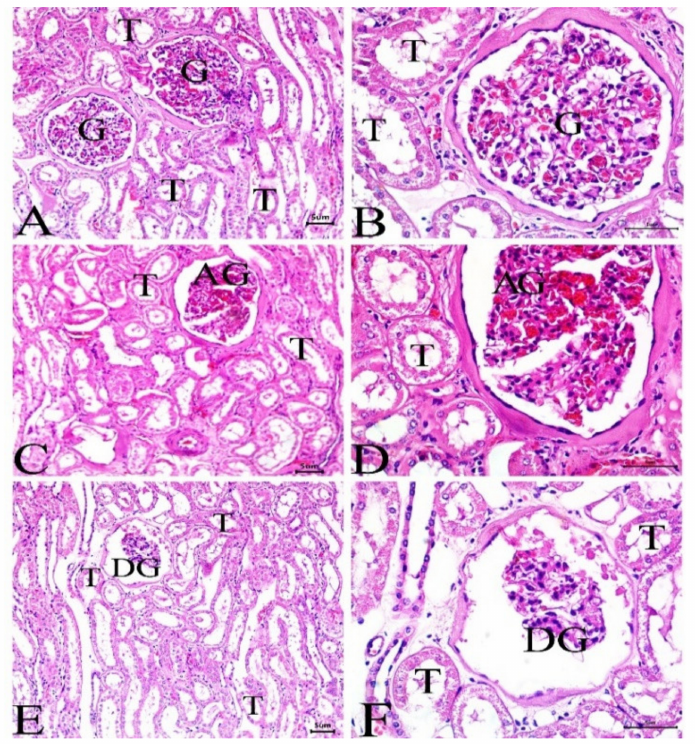
Figure 7. Sections in the kidney of camels at site 1 ( A , B ) showing the normal structure of the glomeruli (G) and renal tubules (T), site 2 ( C , D ) showing mild glomerular abnormalities (AG), and site 3 ( E , F ) showing abnormal and degenerated glomeruli (DG). (H&E, Scale bar = 50 µ